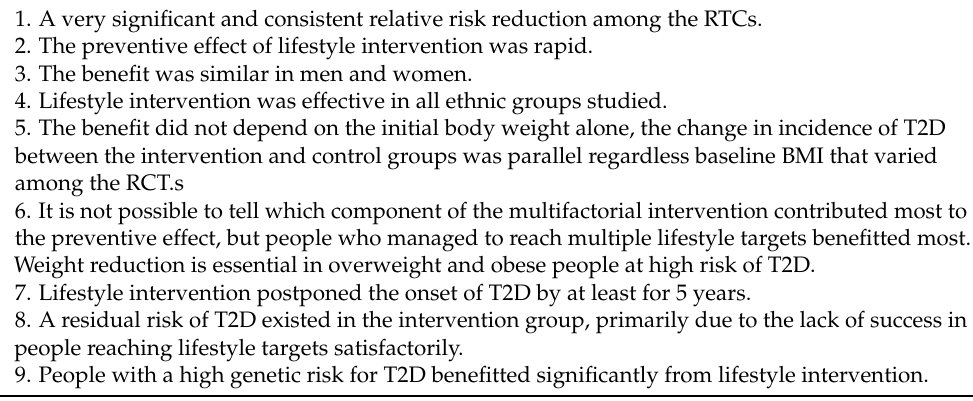
Table 2. The summary of the main results from the major proof-of-concept randomized controlled trials (RCTs) to prevent T2D in high-risk people with lifestyle